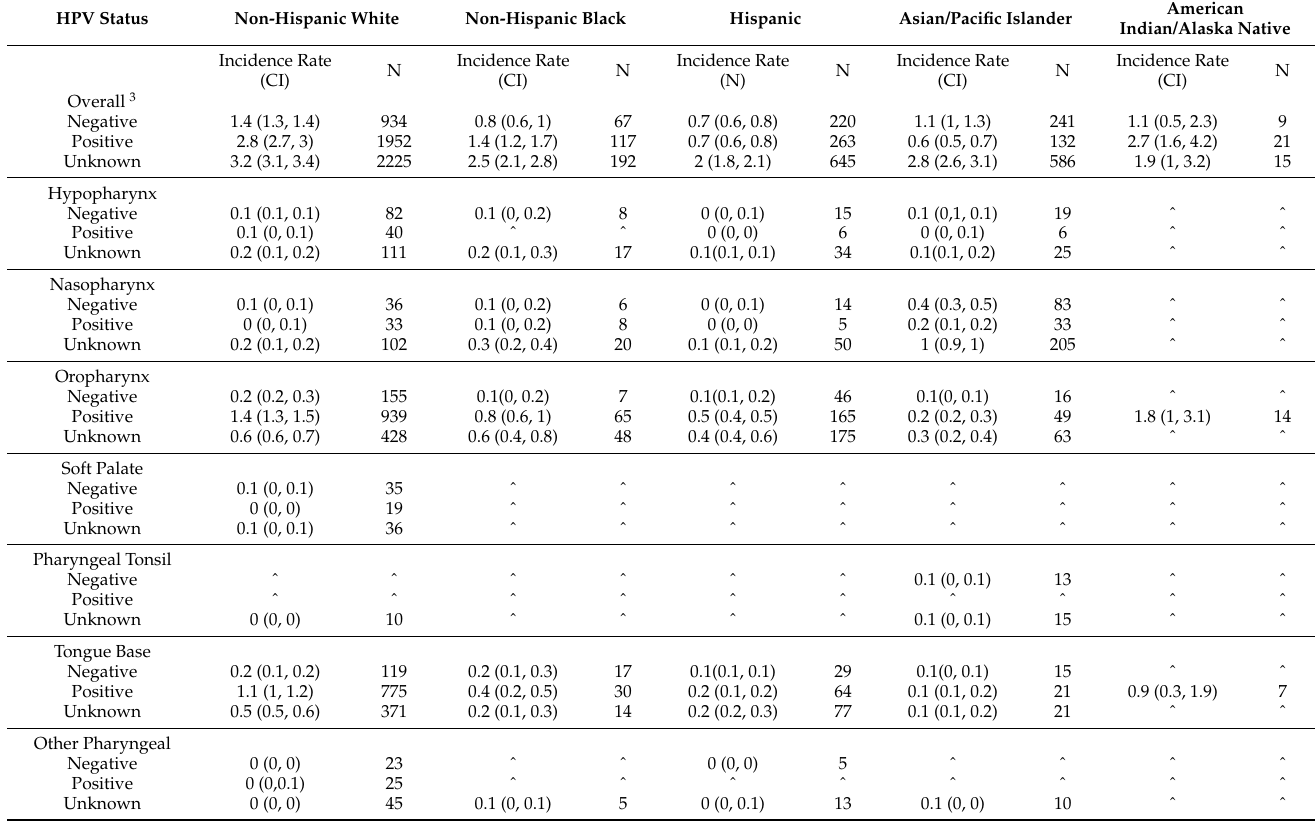
Table 4. Age-adjusted incidence rates 1 of hypopharynx, nasopharynx, oropharynx, soft palate, pharyngeal tonsil, Tongue base, and other pharyngeal cancer, by race/ethnicity and HPV status 2 , 2016–2018 CA. HPV